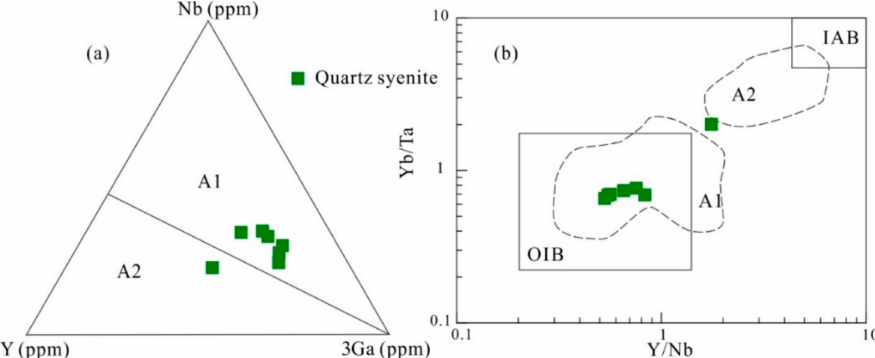
Figure 12. Nb-Y-Ce ( a ) and Yb/Ta-Y/Nb diagrams ( b ) for the QS (modified from [84]). OIB = oceanic island basalt; IAB = island arc basalt. Fields with dashed lines represent A1- and A2-type granites of Eby